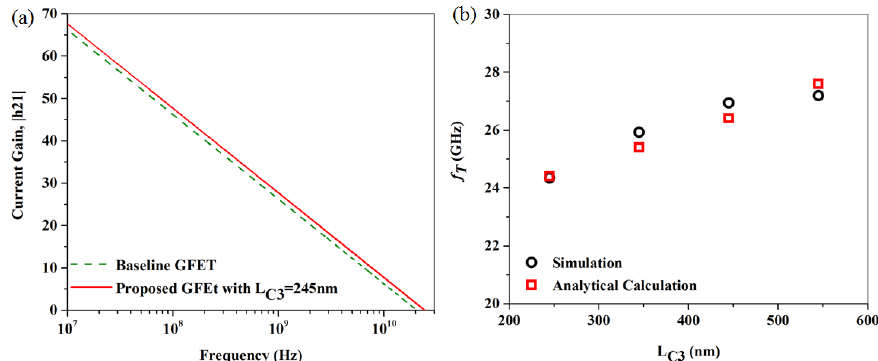
Figure 11. ( a ) Current Gain, |h21| of the baseline GFET-2 along with that of the proposed hybrid contact GFET in the electron regime (V gs = +0.6 V and V ds = +1.6 V) plotted with respect to frequency. ( b ) The current gain cut-off frequency ( f T ) of the proposed GFET extracted from |h21| vs. f characteristics, plotted with respect to L C3